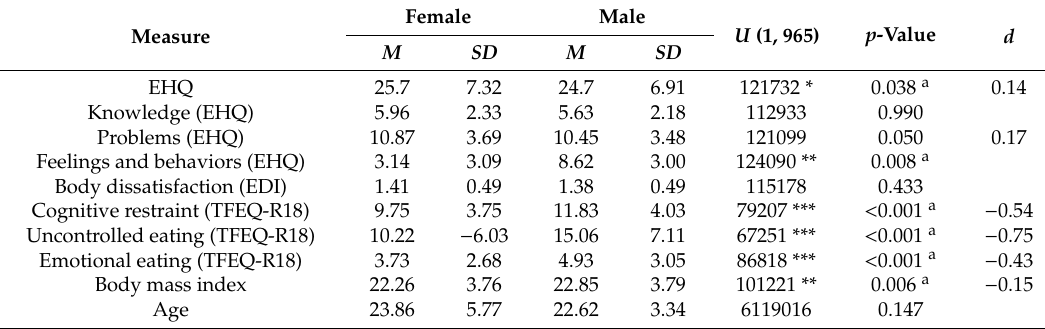
Table 5. Means, standard deviation, and Wilcoxon–Mann–Whitney statistics for study